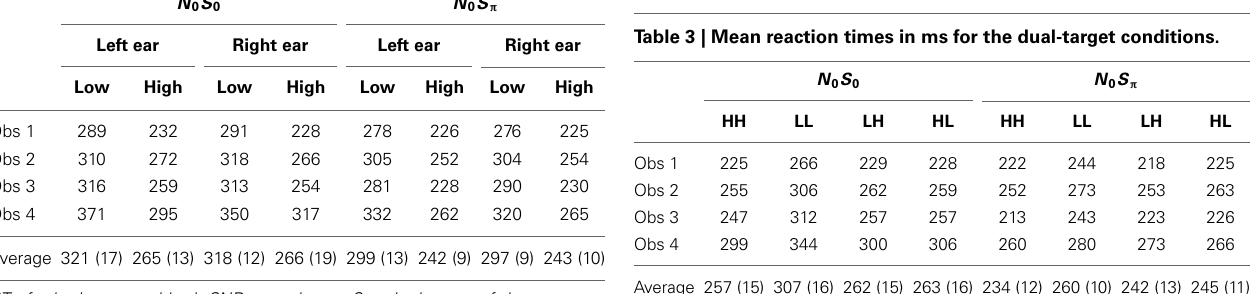
Standard errors of the mean are indicated in parentheses for the